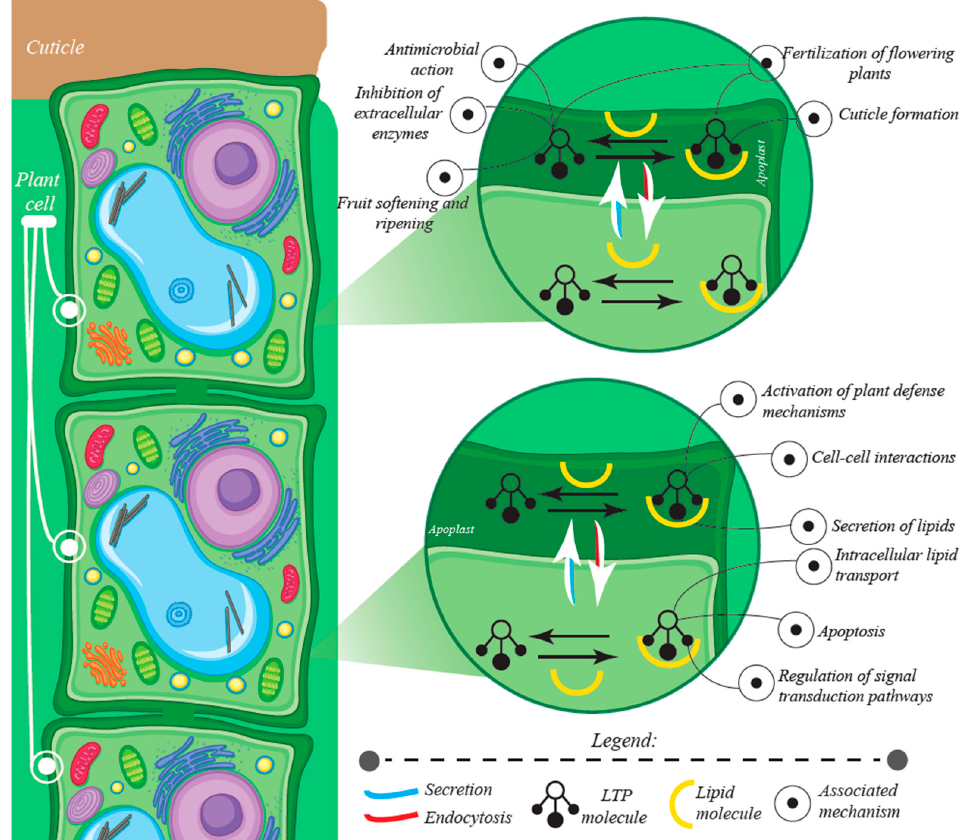
Figure 4. Illustration of possible activities performed locally by lipid transfer proteins in the cell interior, including apoptosis, intracellular lipid transport, regulation of signal transduction pathways, and in the apoplastic route; fertilization, cuticle formation, antimicrobial activity, inhibition of extracellular enzymes, fruit softening and ripening, activation of plant defense mechanisms, cell-cell interactions, and secretion of